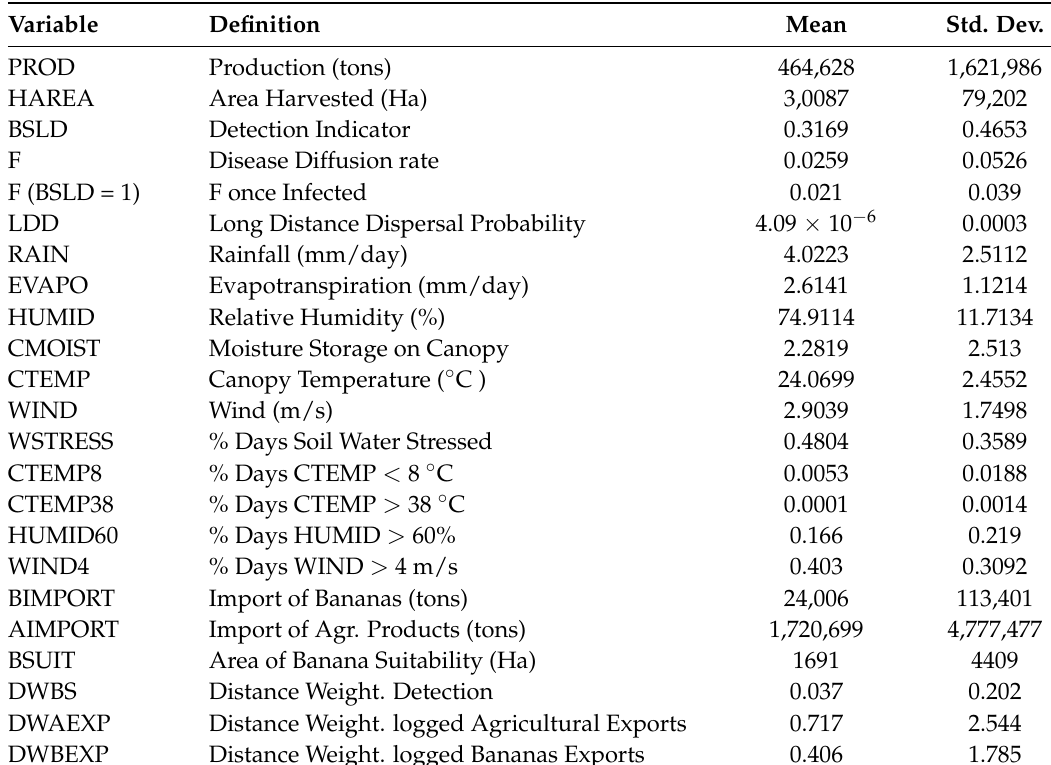
Table 1. Summary statistics.